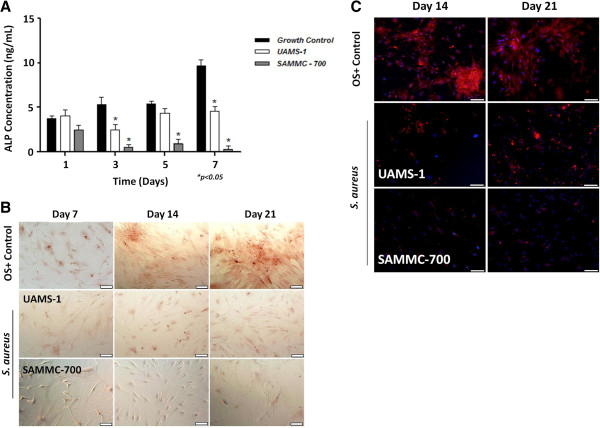
Staphylococcal biofilm factors inhibit osteogenic differentiation in human osteoblasts. A) ALP concentration in osteoblasts exposed to BCM. Bars represent the averages ± std dev from three independent experiments. B) Calcium deposition in osteoblasts and C) osteocalcin in osteoblasts treated with BCM revealed by Alizarin Red S staining and immunofluoresence using specific antibody, respectively. Images were taken at 10× magnification (bars represent 100 μm). Statistical analysis was performed using a One-Way ANOVA analysis using a Bonferroni test to determine statistical differences between groups.* p< 0.01 versus control group.